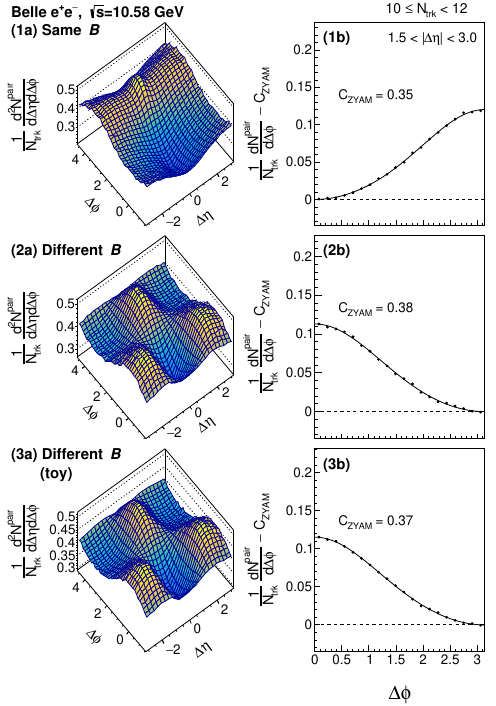
Figure 13. Two-particle correlation functions and long-range ( 1 . 5 ≤ | ∆ η | < 3 . 0 ) ZYAM-subtracted azimuthal differential associated yields for tracks (1) from the same or (2) across different B mesons for every Υ (4 S ) → B ¯ B event with the Belle MC. Panel (3) shows the pairing yields counted from different B mesons from the toy sample mixed from uncorrelated